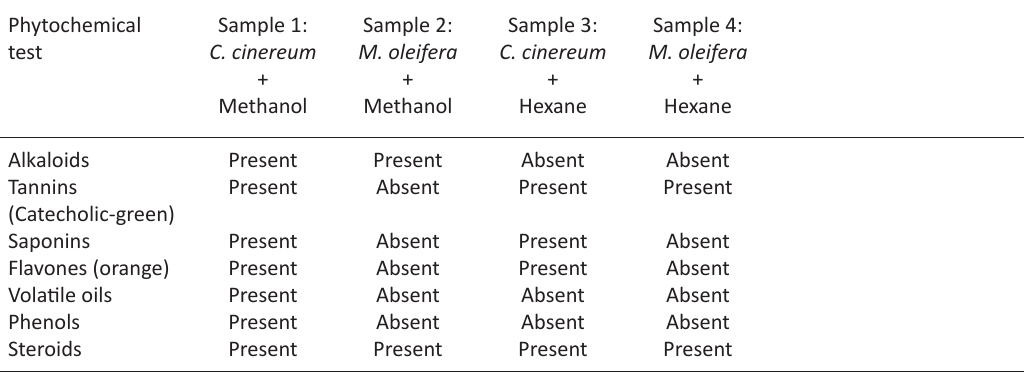
Table 1. Results obtained during phytochemical analysis of the various extracts Phytochemical Sample 1: